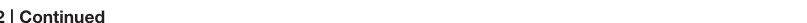
FIGURE 2 | Continued chains with extensive hairy ornamentation from Gruta da Terra Mole (Terceira Island, Azores); (G) Aggregates of coccoid cells with smooth surface and spherical cells arranged in chains resembling beads-on-a-string (arrow) from Bird Park Cave (Hawai`i, U.S.A.); (H) Chain of Streptomyces -like arthrospores from Honda del Bejenado Cave (La Palma Island, Spain); (I) Spores with spiny ornamentation from Helmcken Falls Cave, (British Columbia, Canada); (J) Spiral spore chains of Streptomyces and a coccoid cell with obtuse protuberances (arrow) from Falda de La Horqueta Cave (La Palma Island, Spain); (K) Large spheres with lumpy surface or protuberances connected by a network of filaments or appendages from Gruta dos Montanheiros (Pico Island, Azores); (L) CaCO 3 spheres coated with a filamentous